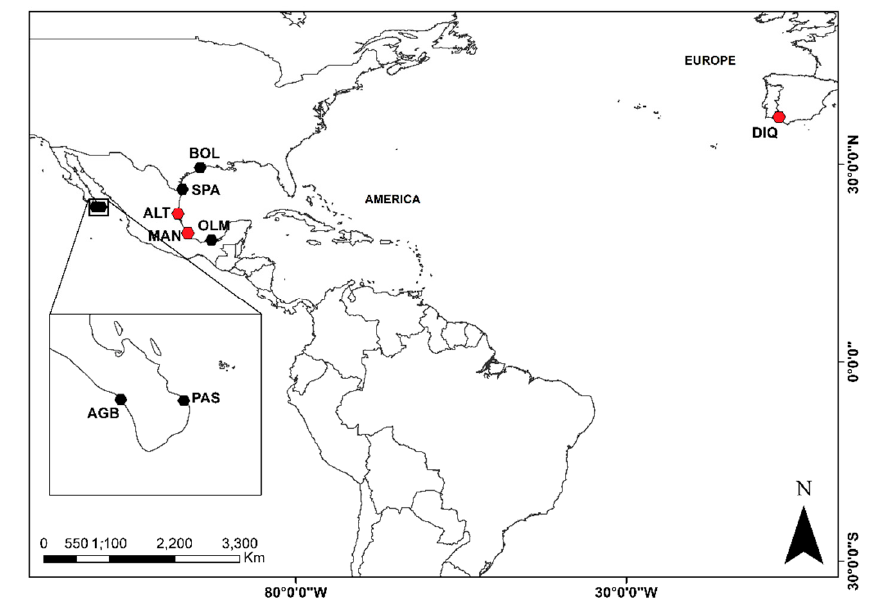
Figure 1. Sampling sites used for the initial screening of microsatellite loci in eight populations of